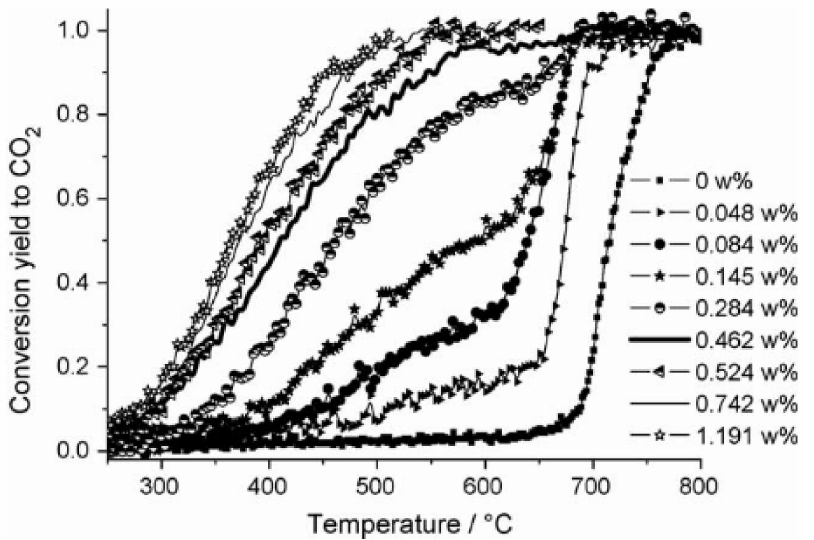
Figure 9. Methane light-off curves over CVD cobalt oxide catalysts as a function of their loadings (reproduced from Ref.